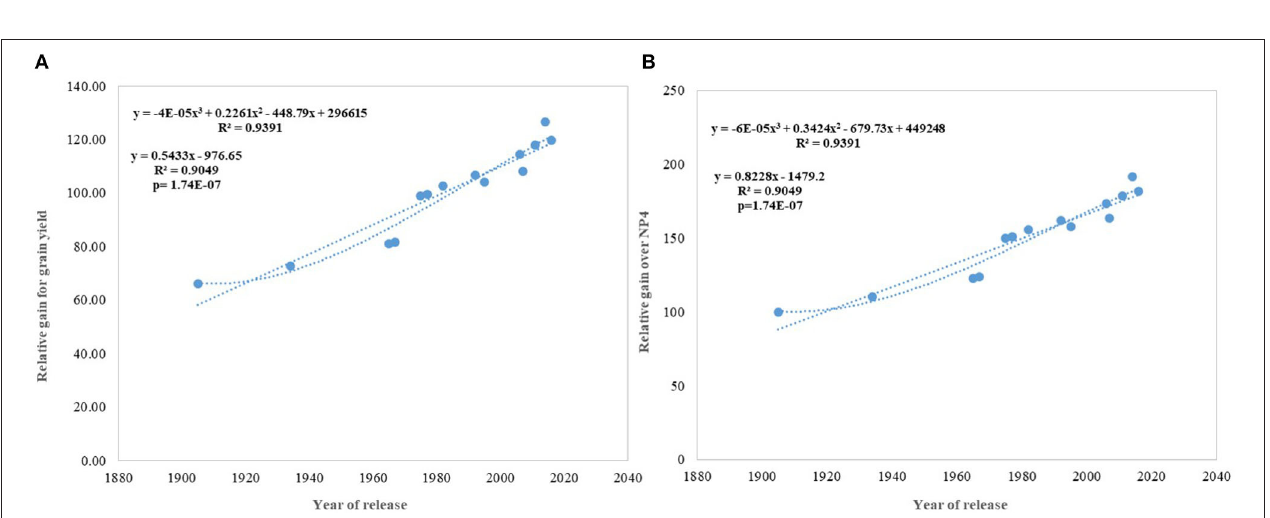
FIGURE 4 | Regression equation between yield and its component traits with the year of release of wheat cultivars. (A) Tiller number per sq m − 1 , (B) Thousand grain weight (g), (C) Grains per spike, (D) Grain yield (Kg ha − 1 ).